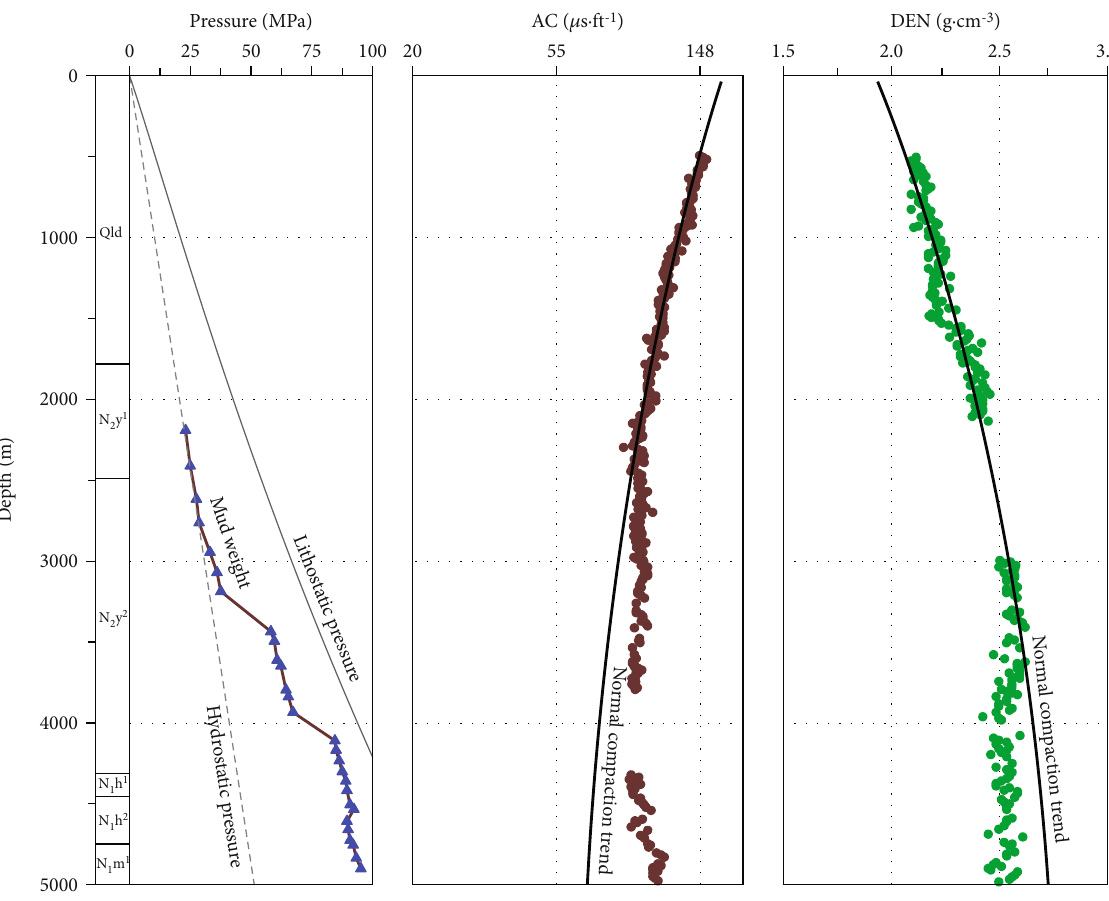
Figure 7: Pro fi les of sonic transit time, density, and mud weight for well C-1 in the Ledong Slope. The location of the well is shown in Figure 1(b).